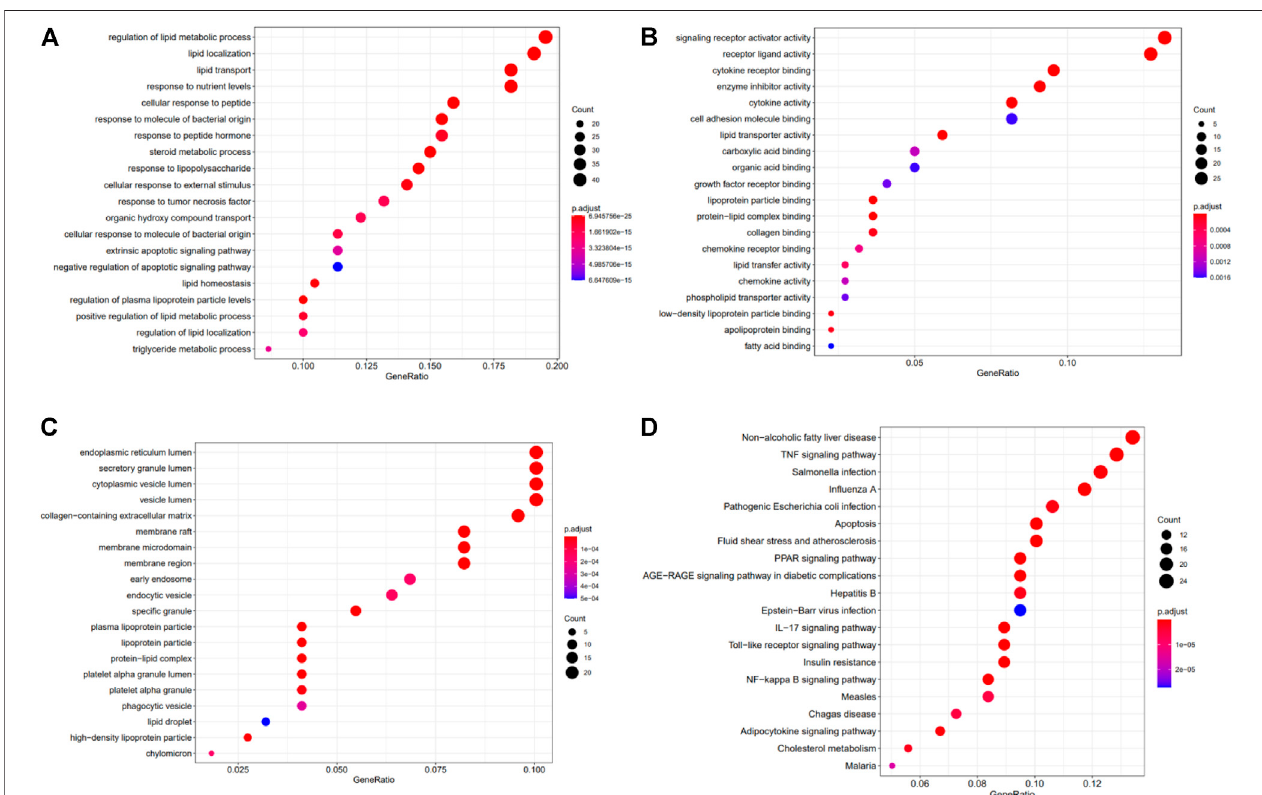
FIGURE 5 | The results of GO and KEGG analyses of the crosstalk genes. GO analysis of the 222 hub genes comprised three aspects: (A) biological process, (B) cellular components, and (C) molecular function. (D) KEGG pathway analysis of the 222 potential target genes.